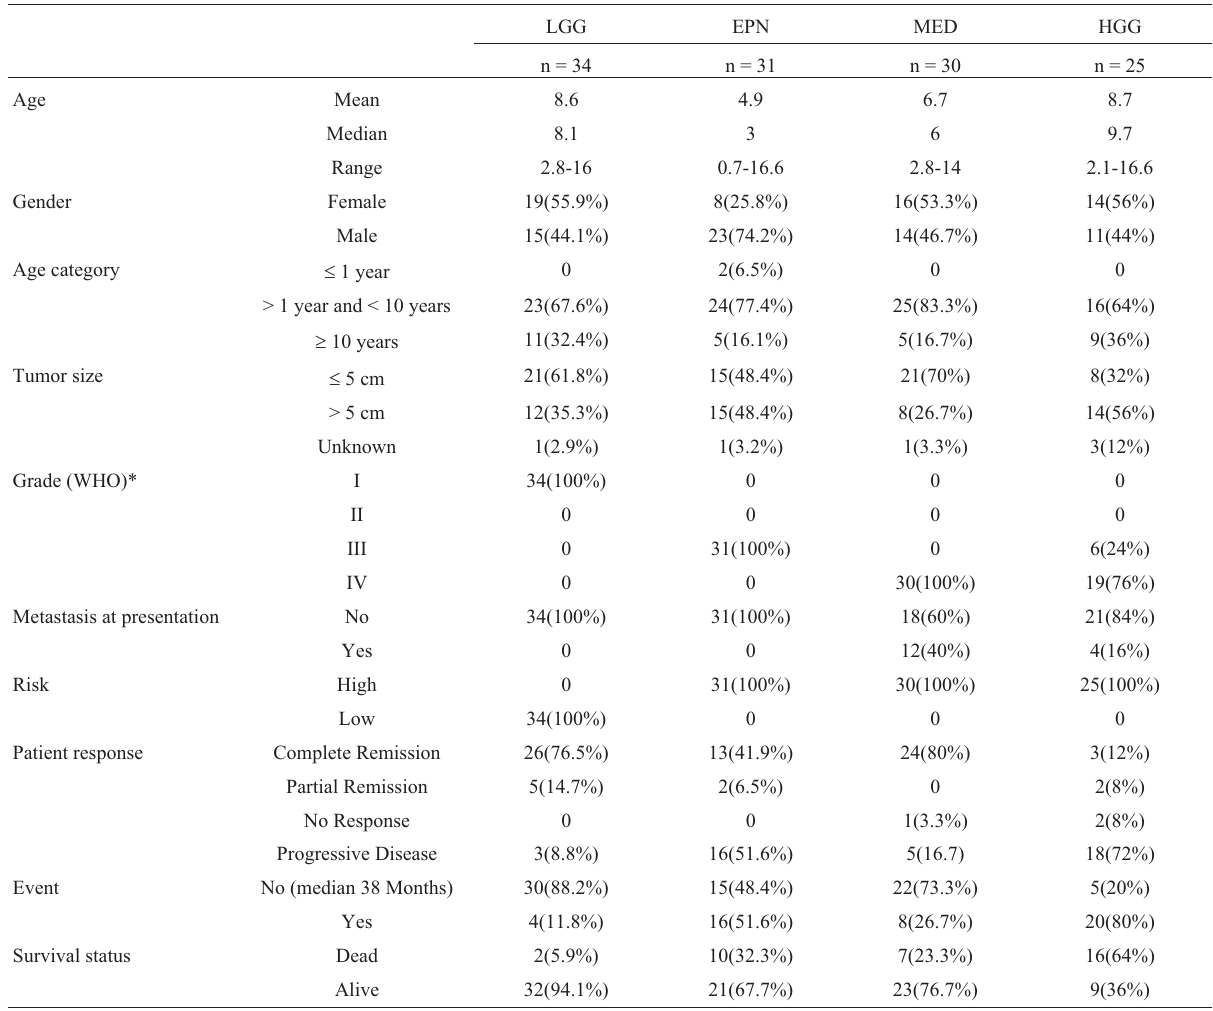
Table 1 - Clinicopathological features of pediatric brain tumor patients enrolled in this